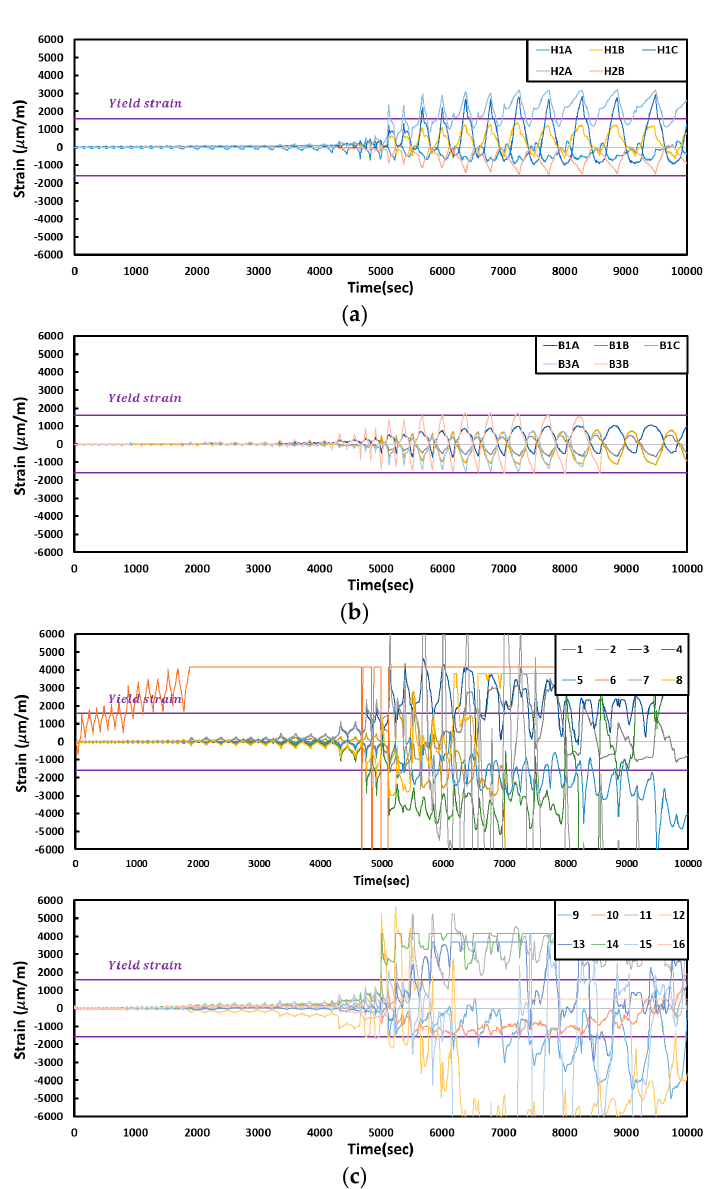
Figure 11. Strain curves of the specimens (FR-TR-V): ( a ) column; ( b ) beam; ( c ) plate.